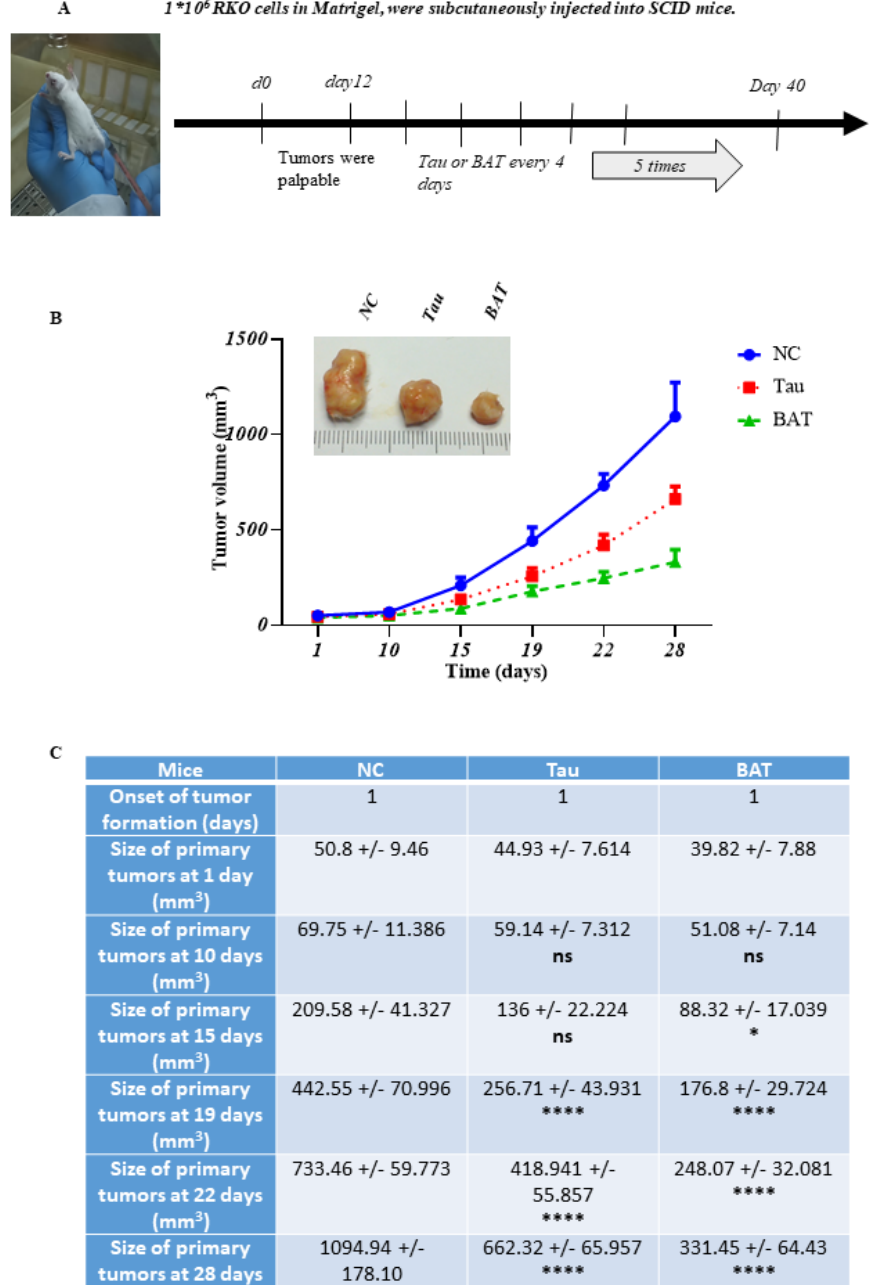
Figure 9. Both BAT and Tau mediate in vivo antitumor action in a xenograft model. ( A ) Schematic experimental design. A total of 1 × 10 6 RKO cells were subcutaneously injected into the right/left flank of severe combined immune-deficient (SCID) mice (day −12). When the tumors became palpable, reaching the appropriate volume of 30–40 mm³ (day 1), the tumor-bearing mice were randomly assigned to 3 groups (6 mice/group). The first group was used as a negative control (NC) group, injected with phosphate buffer solution (PBS), and the other groups received an injection (3 mg/mouse, total 5 doses) of either agent directly into the tumor on specific days according to the timeline. Mice were sacrificed 28 days after the first day of tumor appearance (day 1). ( B ) Graph representation of the mean tumor volume in an approximately 28-day period. ( C ) Statistical analysis of the mean tumor volume between the BAT or Tau-treated groups and the negative control (NC) group. Ns: not significant, * p < 0.05. **** p < 0.0001.